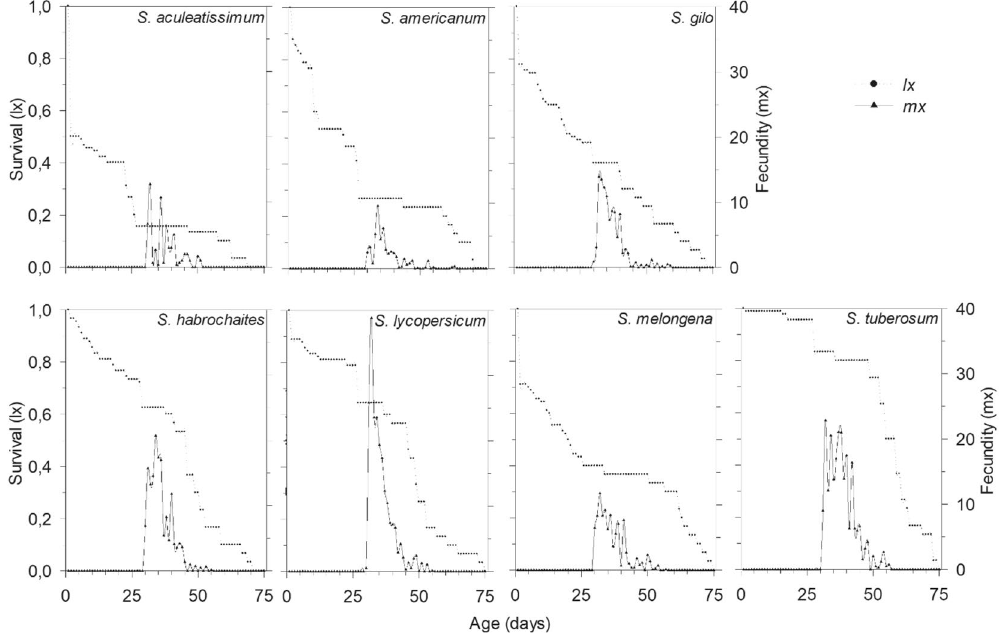
Figure 3. Age-specific survival rates (lx) and fecundity (mx) curves of T. absoluta individuals reared on different host plants. Each curve represents the mean values of six